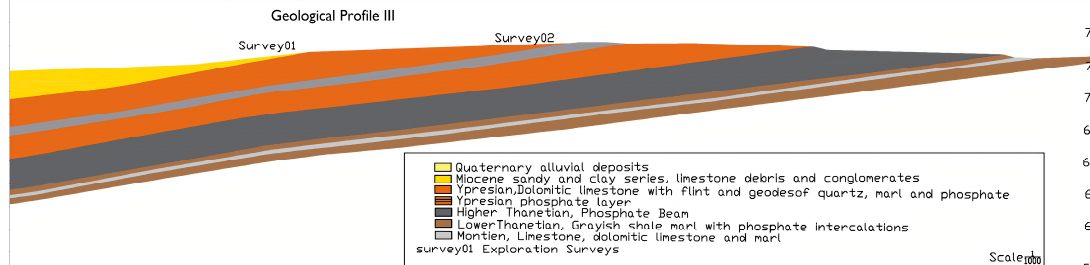
Figure 2. Geological Profile III oriented east–west.